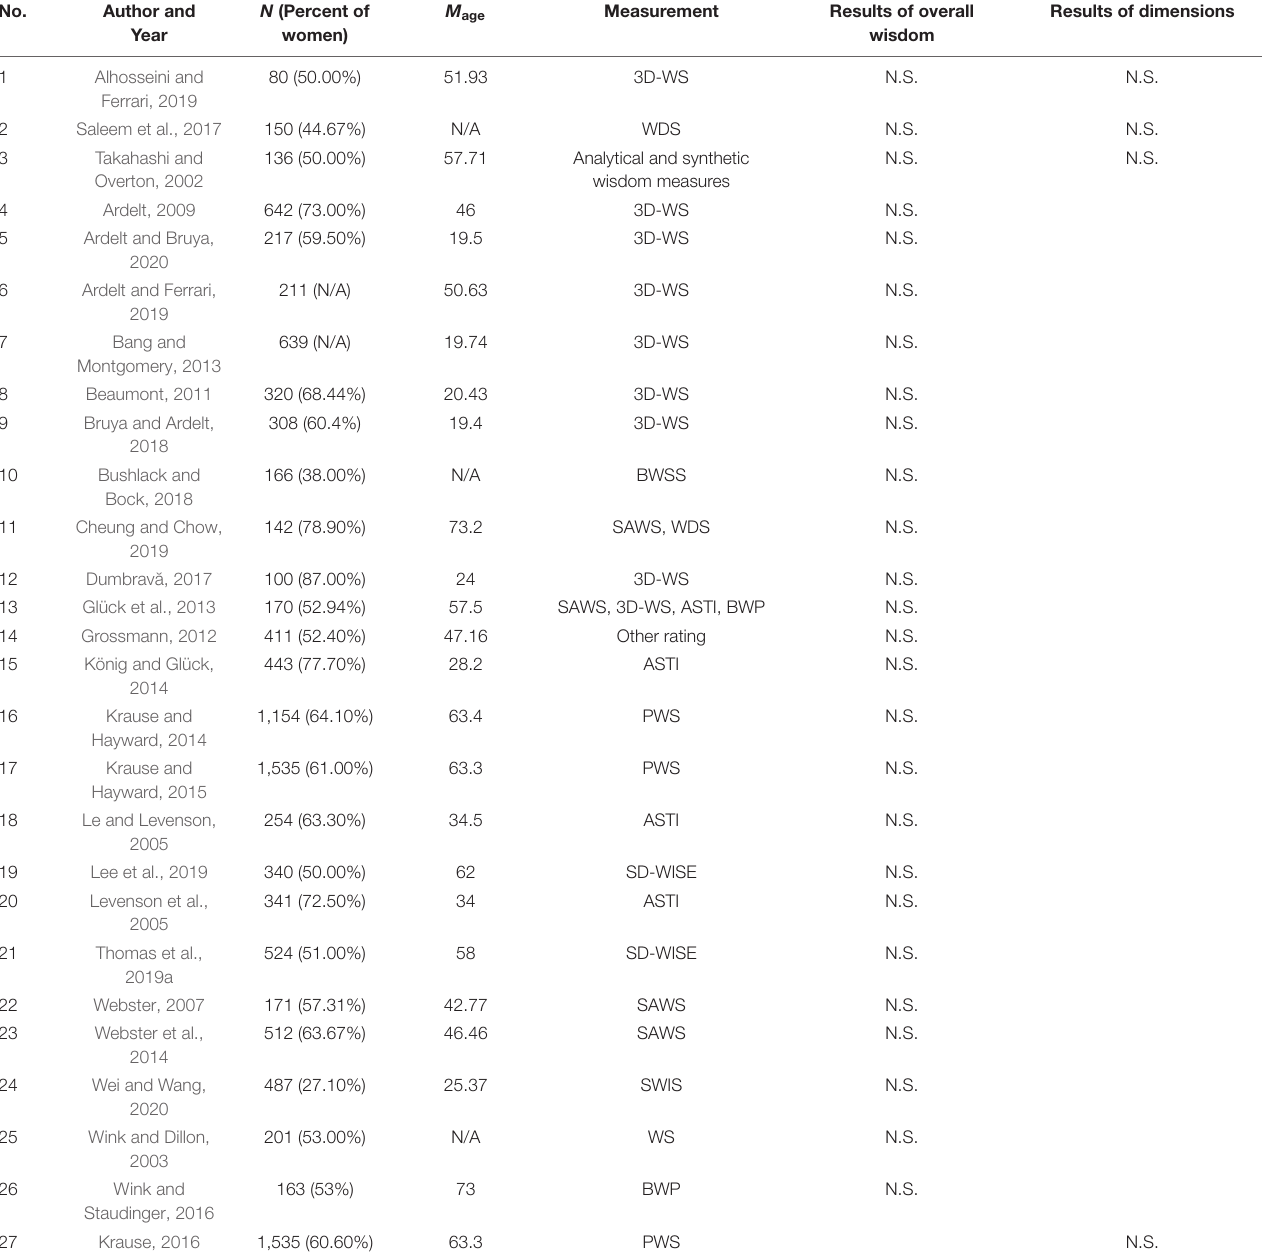
TABLE 1 | Insignificant gender effect on wisdom